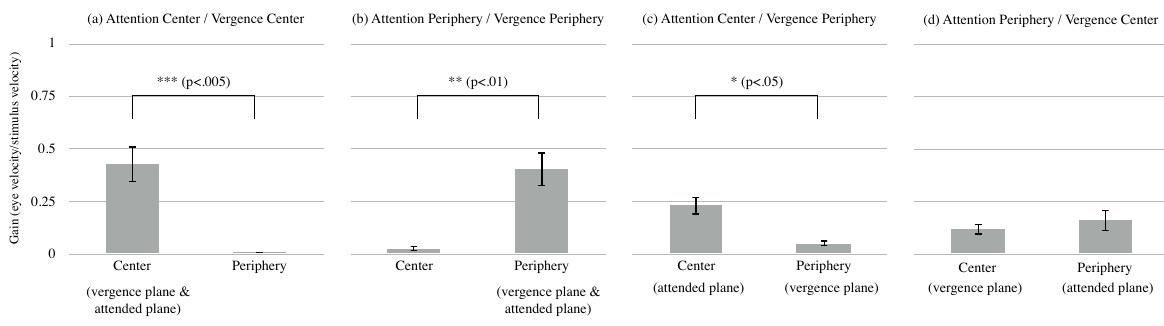
Figure 7. Mean gain of OKN in the experiment for each condition of vergence and attention instructed to direct: The vertical axis presents the gain of OKN corresponding to the motion of each area. Other aspects of the figure are the same as those in Fig